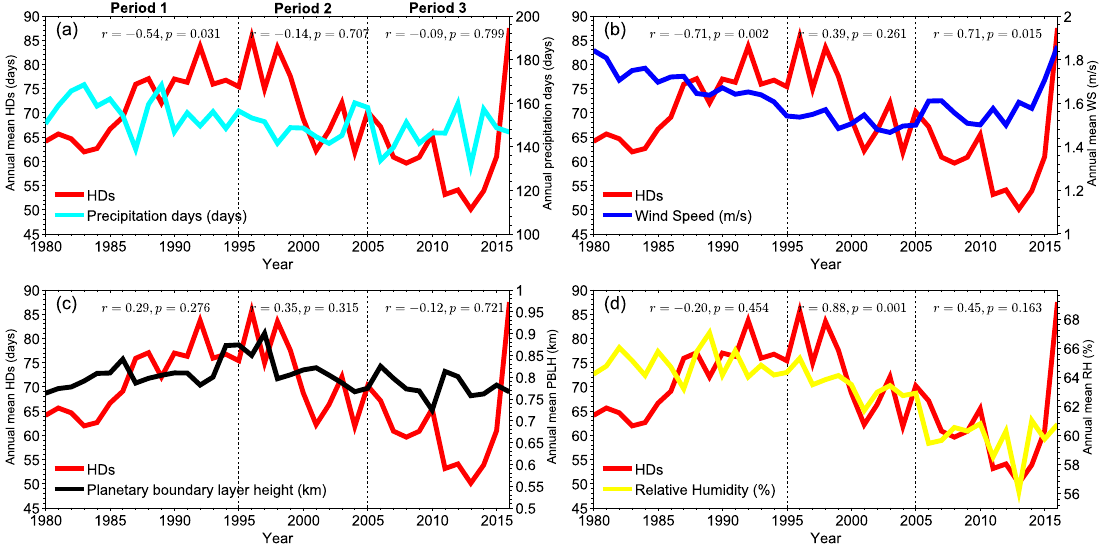
Figure 11. Correlation between annual mean time series of HDs and the four key meteorological parameters, including ( a ) relative humidity at surface; ( b ) wind speed; ( c ) precipitation; and ( d ) planetary boundary layer height, averaged over all stations in SCB for the three periods: 1980–1995, 1996–2005, and 2006–2016. Note that the excluded days are not included in the correlation